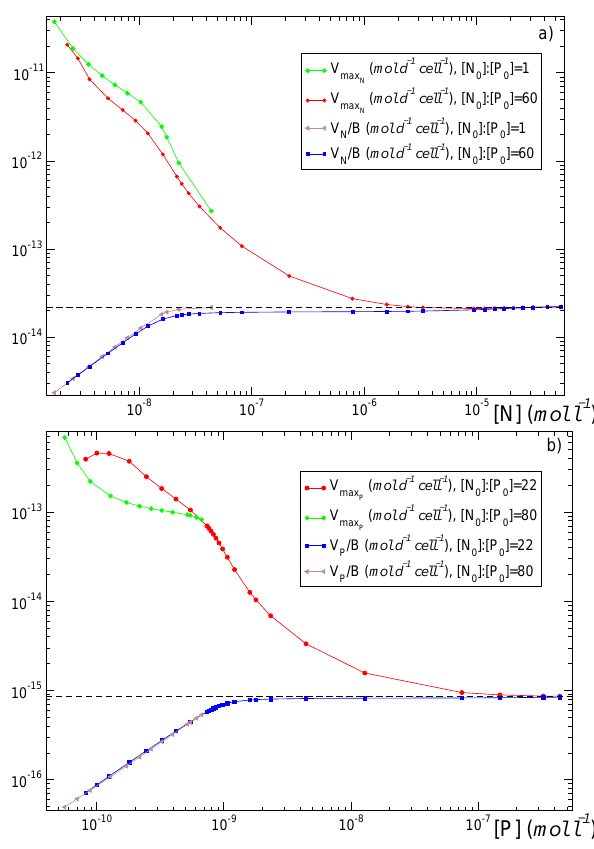
Fig. 9. Different potential outcomes of competition experi- ments between two generic phytoplankton species, A and B for non-interacting (a) and interacting (b) nutrients. The la- beled zones represent situations in which there is an opportu- Fig. 8. Maximum uptake rate V max and per-cell uptake rate V/B nity for co-existence. In the rest of the areas, the outcome de- Fig. 8. Maximum uptake rate V max and per-cell uptake rate for nitrogen (a) and phosphorus (b) as a function of the external (cid:0) (N : P)] = (N : P) pends on each species’ ∆ = [(N : P) V=B for nitrogen (a) and phosphorus (b) as a function of the opt . opt nutrient concentration in the zone of co-limitation. V max decreases In both panels, gray color indicates co-limitation conditions for external nutrient concentration in the zone of co-limitation. with increasing nutrient availability due to the down-regulation of the non-interacting nutrients case (a) For non-interacting nu- V the uptake proteins in the population. V max and V/B converge for max decreases with increasing nutrient availability due to the trients, each species’ optimal ratio [N 0 ] : [P 0 ] opt matches the large nutrient concentrations (dashed lines, see text). down-regulation of the uptake proteins in the population. V max point where co-limitation occurs; the optimal ratios of the two and V=B converge for large nutrient concentrations (dashed species divide the phase diagram, delimiting the co-existence lines, see text). a threshold-like behavior, in which the growth rate curve de- (gray) and exclusion (white) zones. (b) In our model, the opti- pends only on the (non-saturated) quota, and different input mal ratio is one specific point within a wide co-limitation zone, ratio curves collapse to a single curve ( [ N 0 ] : [ P 0 ] < 16 in which is delimited by the ratios at which quotas reach their ef- Fig. 7c and [ N 0 ] : [ P 0 ] > 60 in Fig. 7d); in the zone of co- fective maximum values (saturation points). limitation, however, the growth rate depends on both quo- tas, and the curves change with the value of the input ratio and (rest of [ N 0 ] : [ P 0 ] in Fig. 7c, d). The equality of µ N max µ P results from the dynamics of our model, as do the spe- max cific values of µ N , µ P , V lo , and V lo . These val- max N max P max max ues, contrarily to other models, are not imposed a priori in our case; furthermore, they are in reasonable agreement with static maximum uptake rates measured for Synechococcus (Healey,